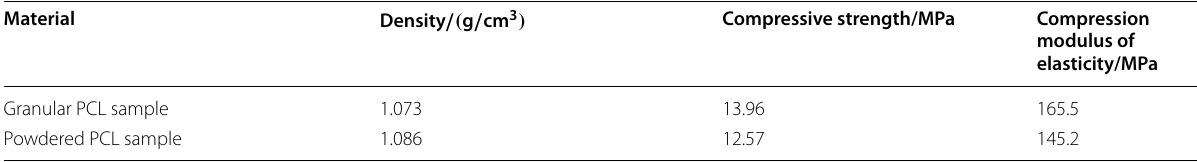
Table 4 Basic physical and mechanical parameters of